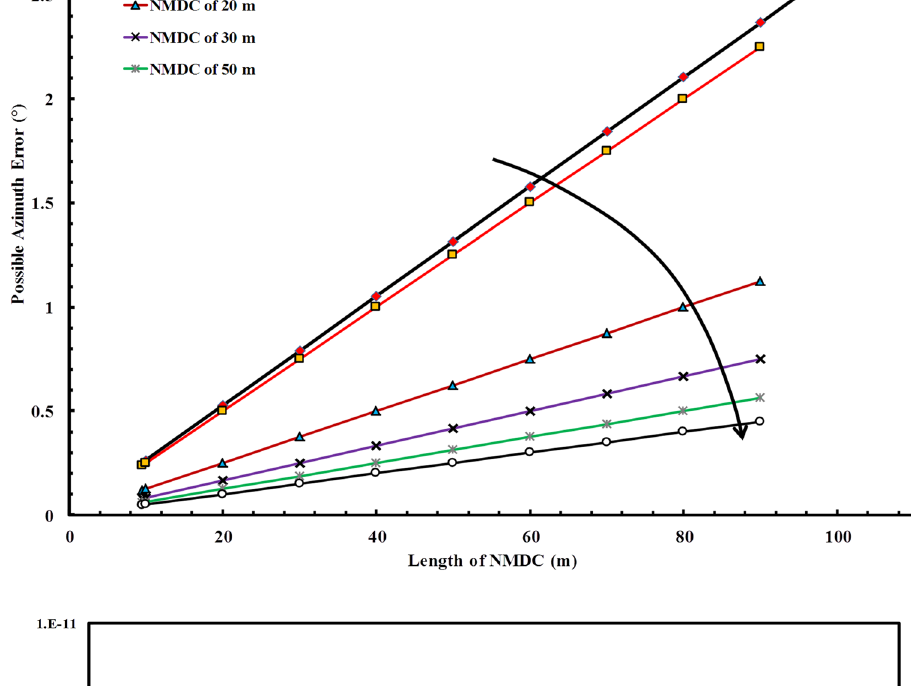
Fig. 6 Impact of NMDC length on Z -axis component of mag- netometer for Barents